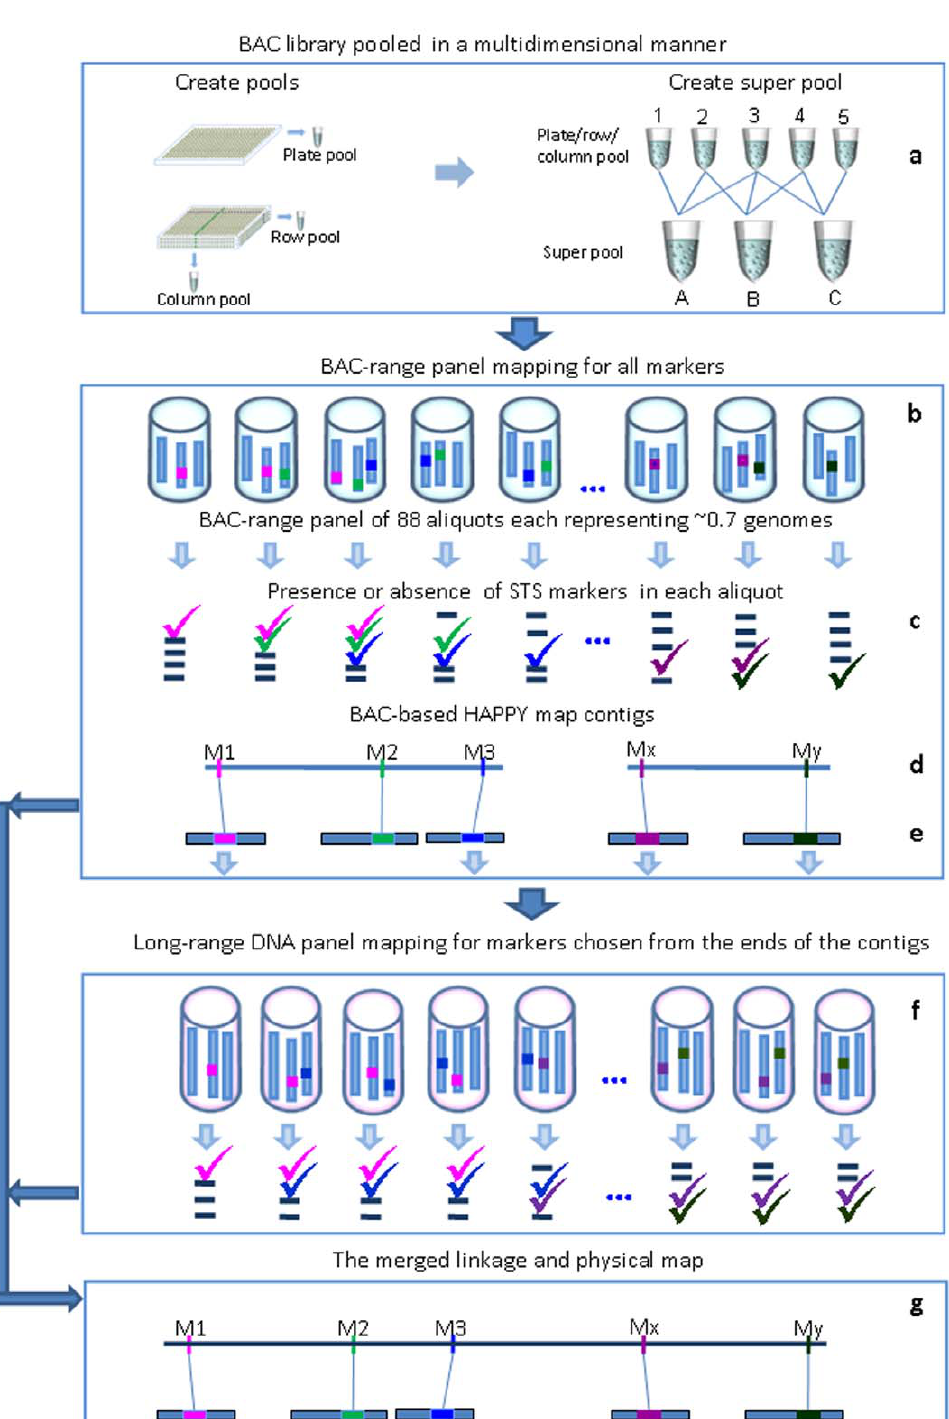
Figure 1. Overview of the BAP mapping method. (a) A genomic BAC library is pooled in a 3-dimensional fashion (1 st D for plate ID; pool all unique clones for each plate and create overlapping superpools of plate pools; 2 nd D for row ID: pool all clones in identical rows over several plates [3.5 plates for Arabidopsis ] and create overlapping ‘superpools’ of row pools to allow row identification; 3 rd D pool for column ID: pool all clones in identical columns over several plates [3.5 plates for Arabidopsis ] and create overlapping ‘superpools’ of column pools to allow column identification) to generate the BAC-range panel.(b)Of96wellsofaplate,88containrandomaliquotsofa BAClibrary(8wells arereservedforcontrols),eachBACaliquotcontains DNAcorresponding 0.6–0.7 fold coverage of the genome. The presence of single copy STS markers (M1-My) is indicated by various colours in the aliquots. (c) The presence of markers found after MT-PCR-HRM. (d) The BAC range panel mapping results allow creation of short linkage maps, and (e) at the same time, to establish a corresponding BAC tiling path.(f) To link the shorter contigs obtained fromtheBAC panel andto closethe gapsbetween contigs,markers chosen from the ends of the contigs are mapped by the long-range (large size) DNA panel. (g) The merged linkage and physical map as the final result.